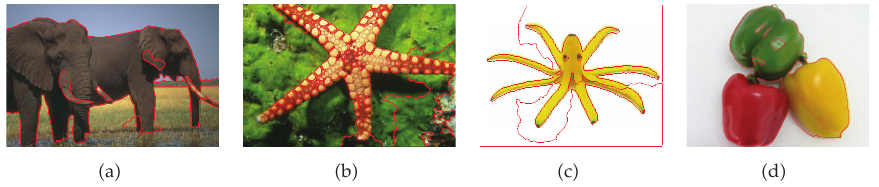
Figure 11: Results of the SBRSF model for some color images from Figures 8, 9, and 10. The initial contours for these images are the same as used in the proposed